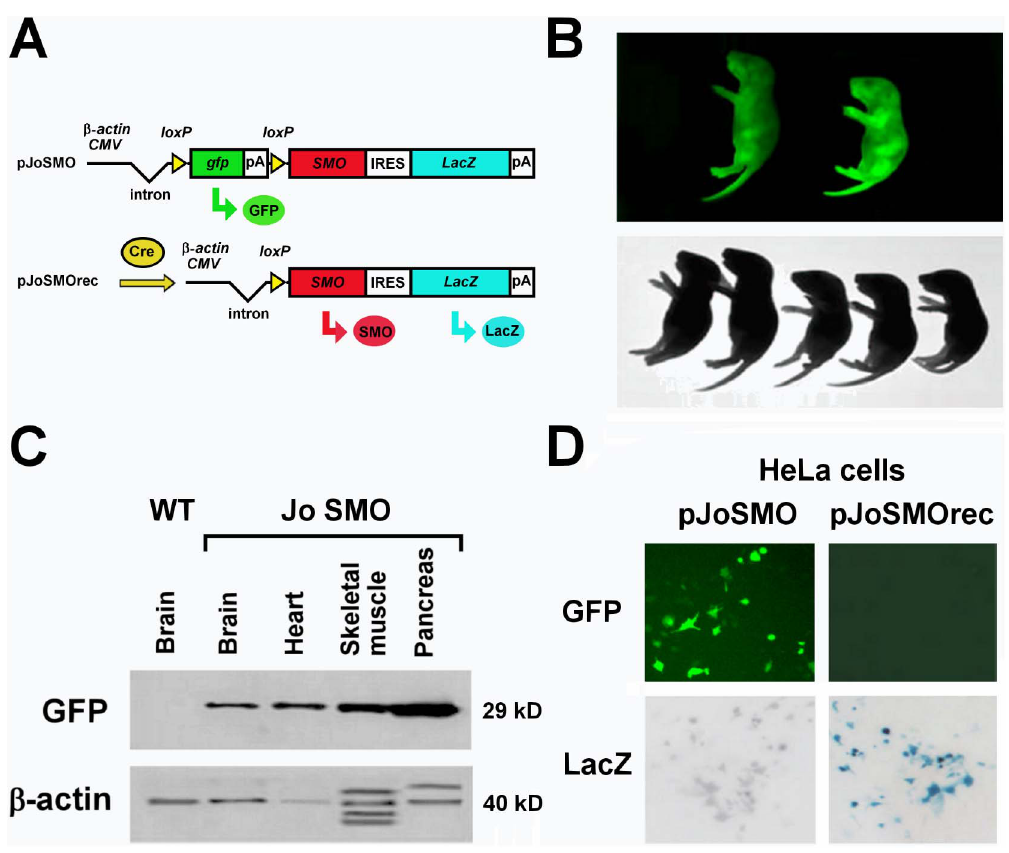
Figure 1. JoSMO mouse line generation. A . Scheme of pJoSMO and, upon Cre recombination, of pJoSMOrec plasmids. The b -actin/CMV fusion promoter drives the ubiquitous expression of the gfp (green arrow, Green Fluorescent Protein) reporter gene. Upon Cre recombination the gfp -stop cassette is excised, leading to simultaneous expression of SMO (red arrow) and of the second reporter gene, lacZ (blue arrow, b -galactosidase), via an IRES sequence. B . JoSMO mice exhibited widespread GFP fluorescence. C . Western blot analysis confirms the presence of GFP in different organs. D . The Cre recombination was analysed with pJoSMO and pJoSMOrec plasmids transfection in HeLa cells. After transfection, GFP fluorescence and LacZ staining on HeLa cells were monitored.